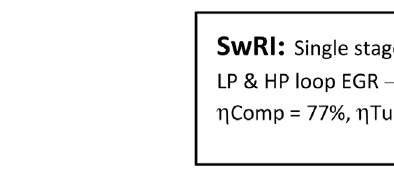
FIGURE 17 | Turbine ef fi ciency comparison.